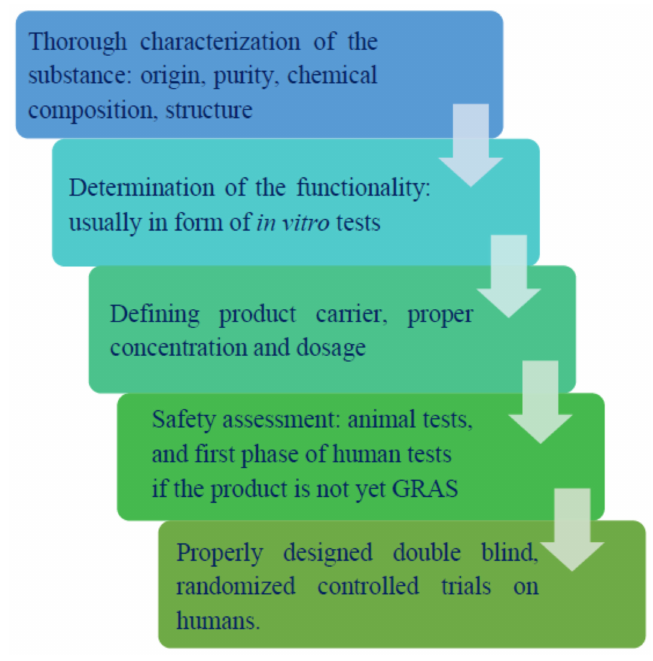
Figure 1. Steps of prebiotic